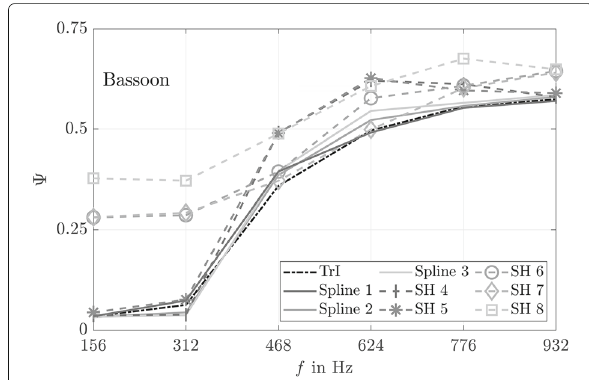
Fig. 6 The global error measure (cid:9) of all six examined directivities of the bassoon plotted individually. The black dashed line represents the triangular interpolation (TrI) error. The solid lines show the reproduction error when interpolating the radiation patterns with the spline approach for M = { 1,2,3 } ; the gray dashed lines indicate the error of SH interpolations for N = { 4,5,...,8 }